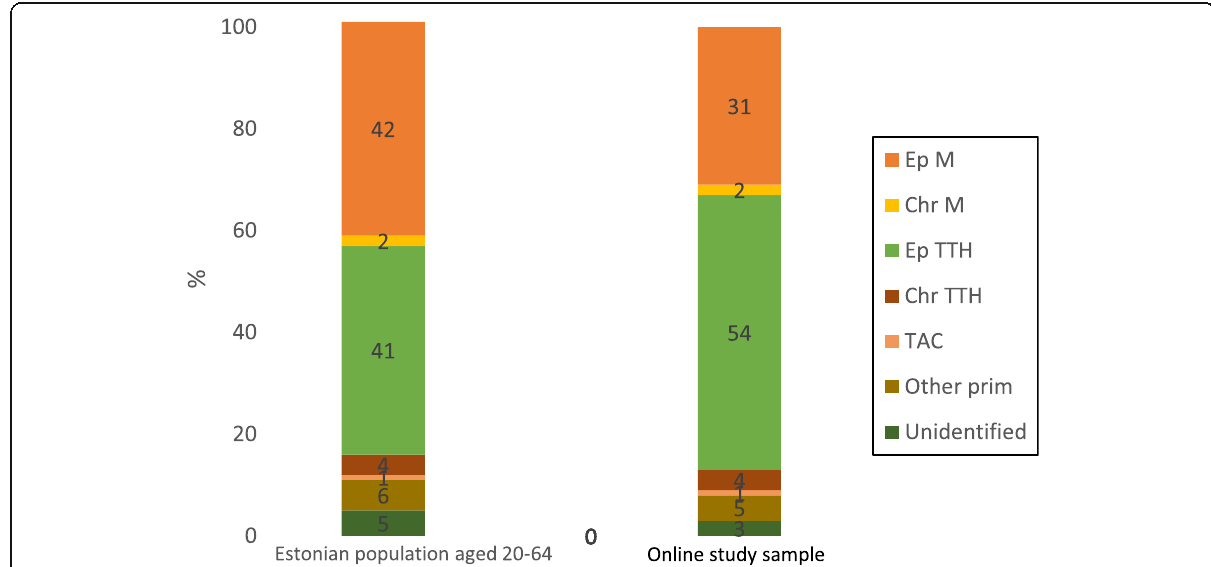
Fig. 2 Proportions of different primary headache diagnoses among headache sufferers in the two samples. Ep M: episodic migraine; Chr M: chronic migraine; Ep TTH: episodic tension type headache; Chr TTH: chronic tension type headache; Other prim: other primary headaches; TAC: trigeminal autonomic cephalalgias